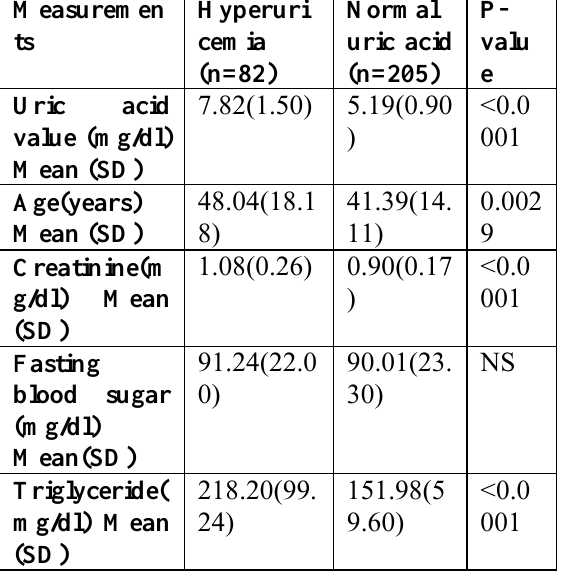
Table No. 4.5 Single Variable Analysis of Hyperuricemia and Measurements